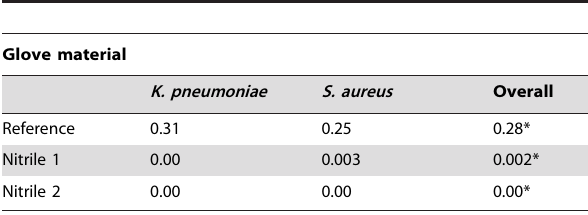
Table S2 Inhibition zones, Nitrile Type 1 - KIMTECH PURE